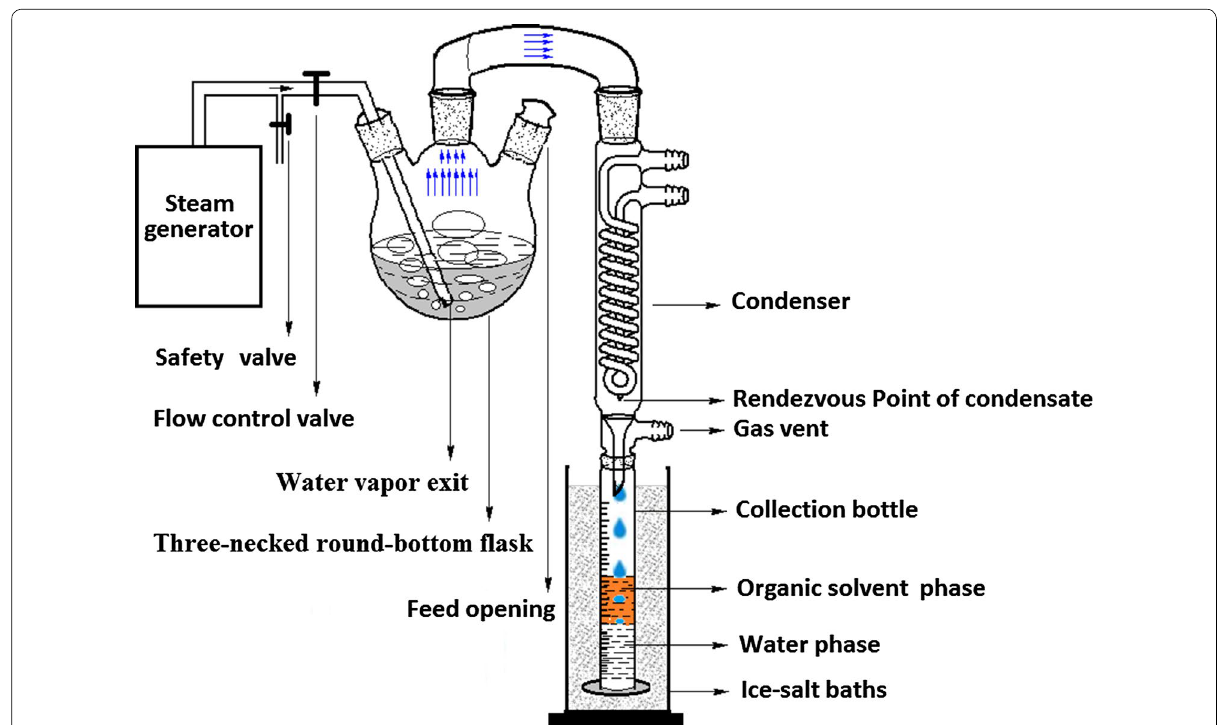
Fig. 1 The diagram of steam distillation/drop‑by‑drop extraction device. (The device is suitable for extraction of volatile oils from extract. e.g. The jujube extract is produced by the following procedure: The jujube fruit was cleaned and denucleated. The pitted jujubes were then crumbed and extracted using alcohol. Then, the solvent was removed to produce the jujube